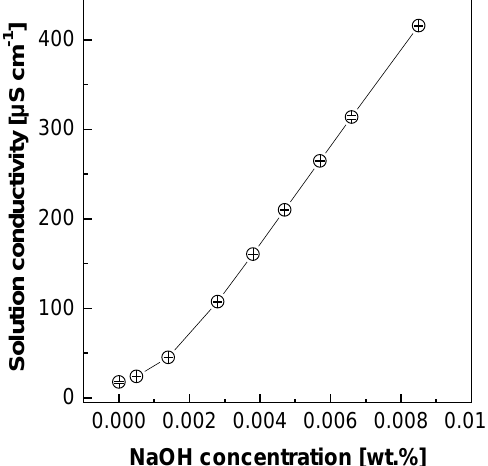
Figure 2. Schematic diagram of the two-chamber diffusion cell used in this study.